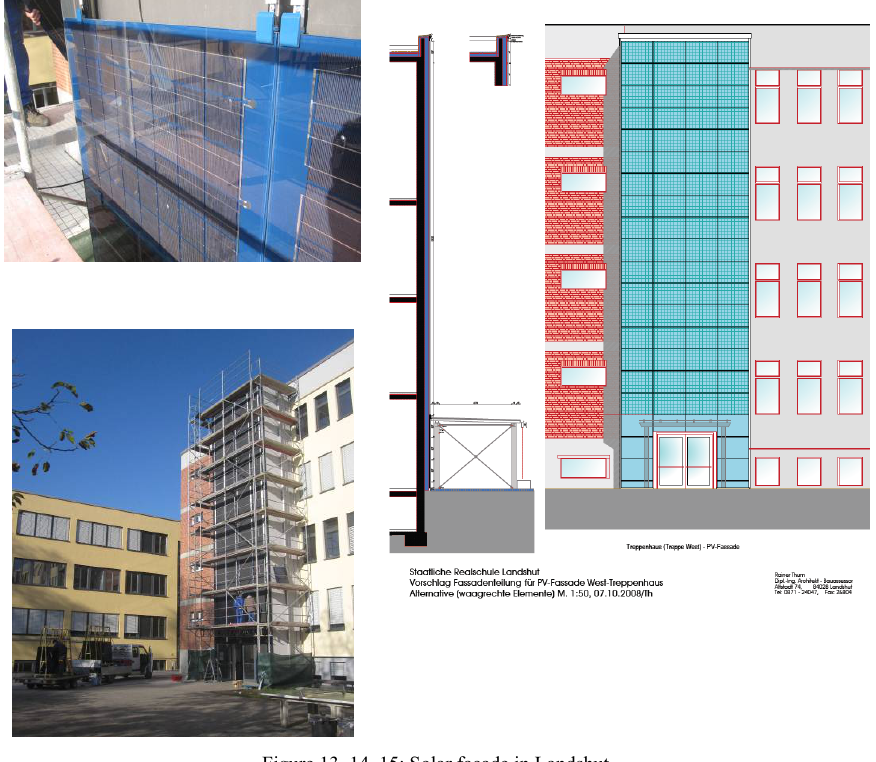
Figure 13, 14, 15: Solar façade in Landshut